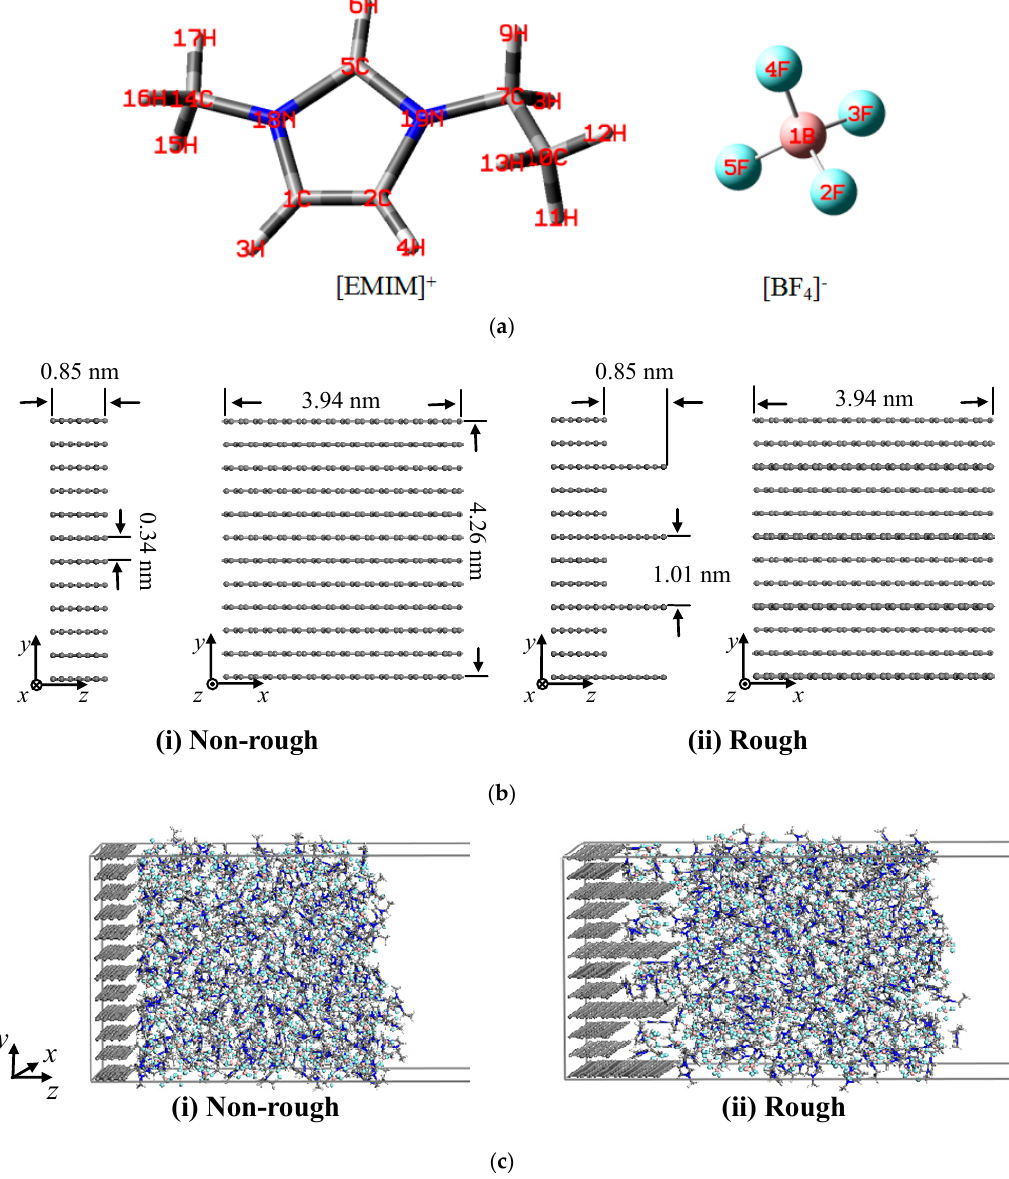
Figure 1. The detailed illustration of the simulation system: ( a ) ion structure of [EMIM] + and [BF 4 ] − , ( b ) stack structure of graphene electrode, ( c ) interface models of graphene/ion liquid with non-rough and rough graphene surface.